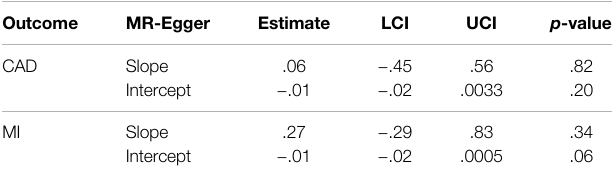
TABLE 2 | MR-Egger tests of intelligence with CAD and